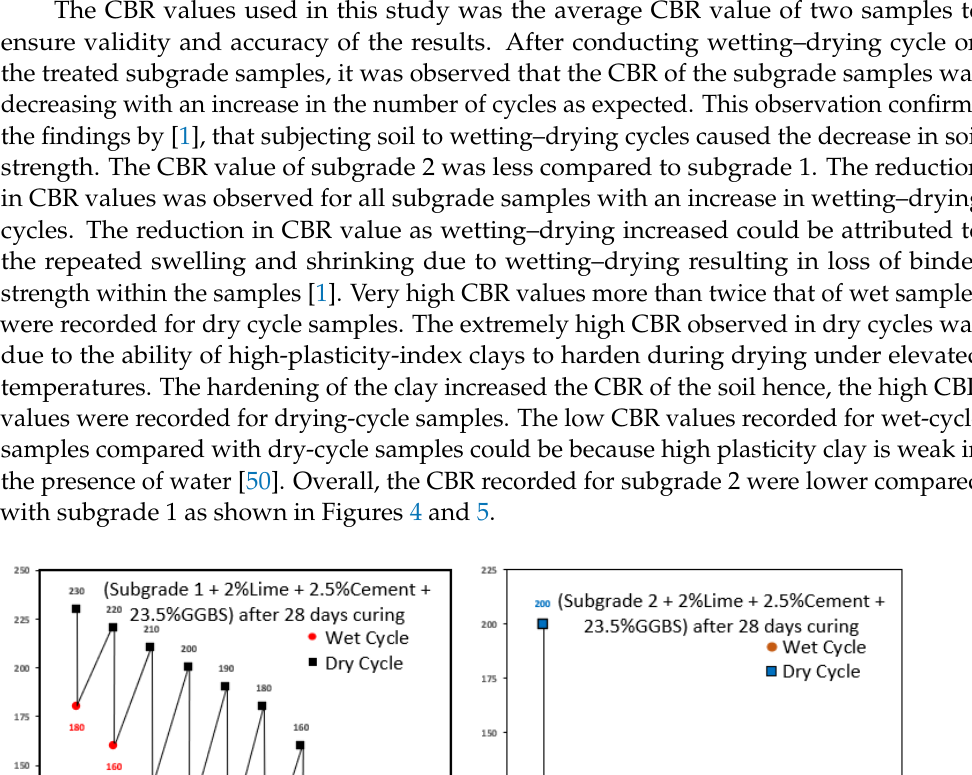
Figure 5. ( a ) Wetting – drying cycle results for subgrade 1 composed of GGBS and BDW after 28 days of curing. ( b ) Wetting – drying cycle results for subgrade 2 composed of GGBS and BDW after 28 days of curing. This was due to the high amount of bentonite content in the mix, making it expansive and weak in compression. According to [12], subgrade materials with high bentonite con- tent have low CBR values. Subgrade mix design composed of high GGBS content (23.5%) recorded the highest CBR values for wetting – drying cycles, making it the best performing mix in this study. The high strength values achieved with the addition of high amounts of GGBS in the mix supports some of the results presented by [12], which is because the relatively high calcium content in GGBS, the main reaction product of CSH gel is respon- sible for the increase in strength in a mix [51]. Studies have shown that the higher the amount of GGBS blends, the greater the strength and durability of the mix [52]. This shows that subgrade material treated with 23.5% GGBS can withstand many wetting – drying cy- cles and still maintain very high CBR values required for use in road construction. The